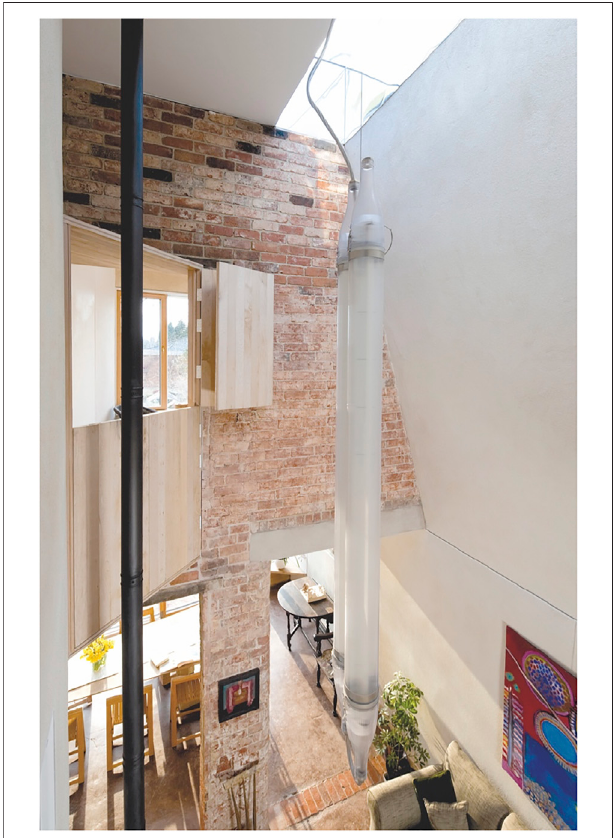
FIGURE 3 | Double-height space living room (with permission from Martine Hamilton